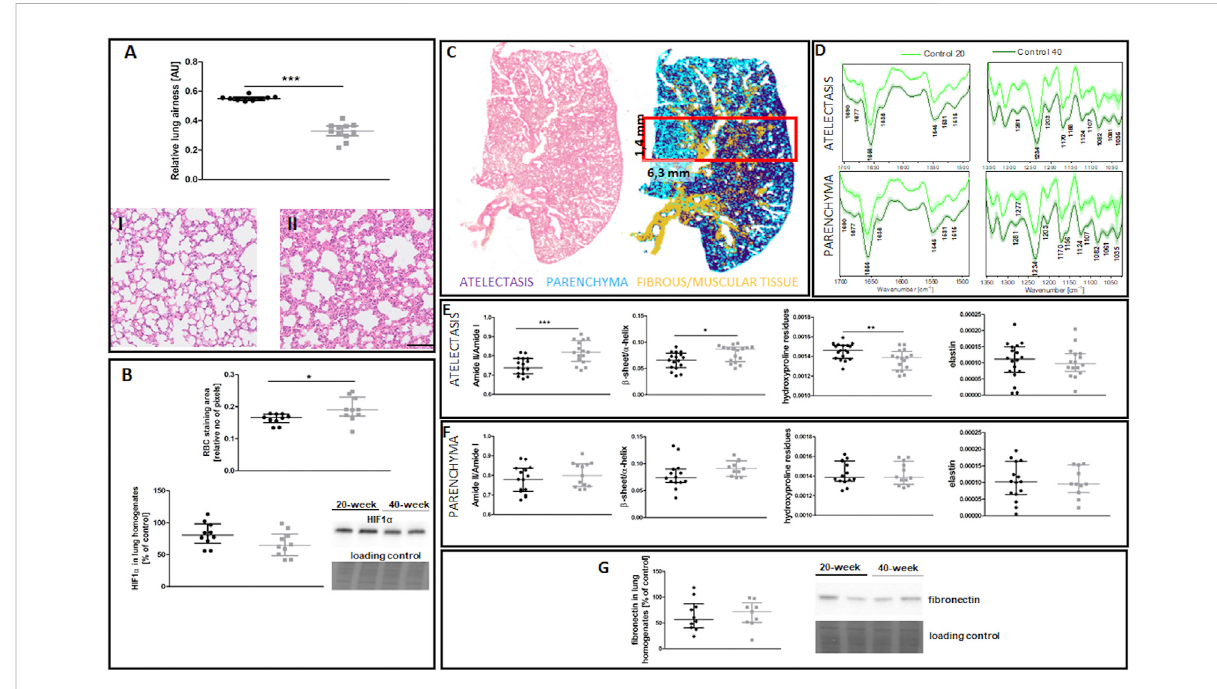
FIGURE 4 Lung ECM remodelling in untreated control 20-week-old and 40-week-old BALB/c mice. Black symbols denote control untreated 20-week- old mice, and grey symbols denote control untreated 40-week-old mice. (A) Relative lung airness ( n = 10 – 11). Representative H&E stained sections oflungparenchymaat×200magni fi cationfor20-week-oldand40-week-oldmiceareshownin (I) and (II) ,respectively. (B) RBCnumbersandHIF1 α levelsinthelungparenchyma( n =10).AcomparisonofH&Estainingandthefalse-colourclustermapoftheIRimageshowingdifferentiationof main morphological structures in lungs is shown in (C) , while averaged second derivative FTIR spectra [±standard deviation (SD)] of each group is shown in (D) . Semi-quantitative analyses of biomolecules in the atelectasis ( n = 16 – 18) (E) and (F) lung parenchyma ( n = 10 – 14), and (G) fi bronectin levels in lung homogenates ( n = 10) are shown by a representative western blot. Integration regions: Amide II/I [(1589 – 1485 cm − 1 )/ (1707 – 1608 cm − 1 )], β -sheet/ α -helix [(1640 – 1623 cm − 1 )/(1670 – 1640 cm − 1 )], hydroxyproline residues (1187 – 1140 cm − 1 ), and elastin (1070 – 1040 cm − 1 ).Thescalebarin (A) represents100 μ m.DataarepresentedasdotplotsshowingthemedianandIQR.Alldatawerecomparedwith an unpaired Student ’ s t -test except for β -sheet/ α -helix in (C) which were compared with a Mann-Whitney U test. Key: * p < 0.05; ** p < 0.01; *** p <